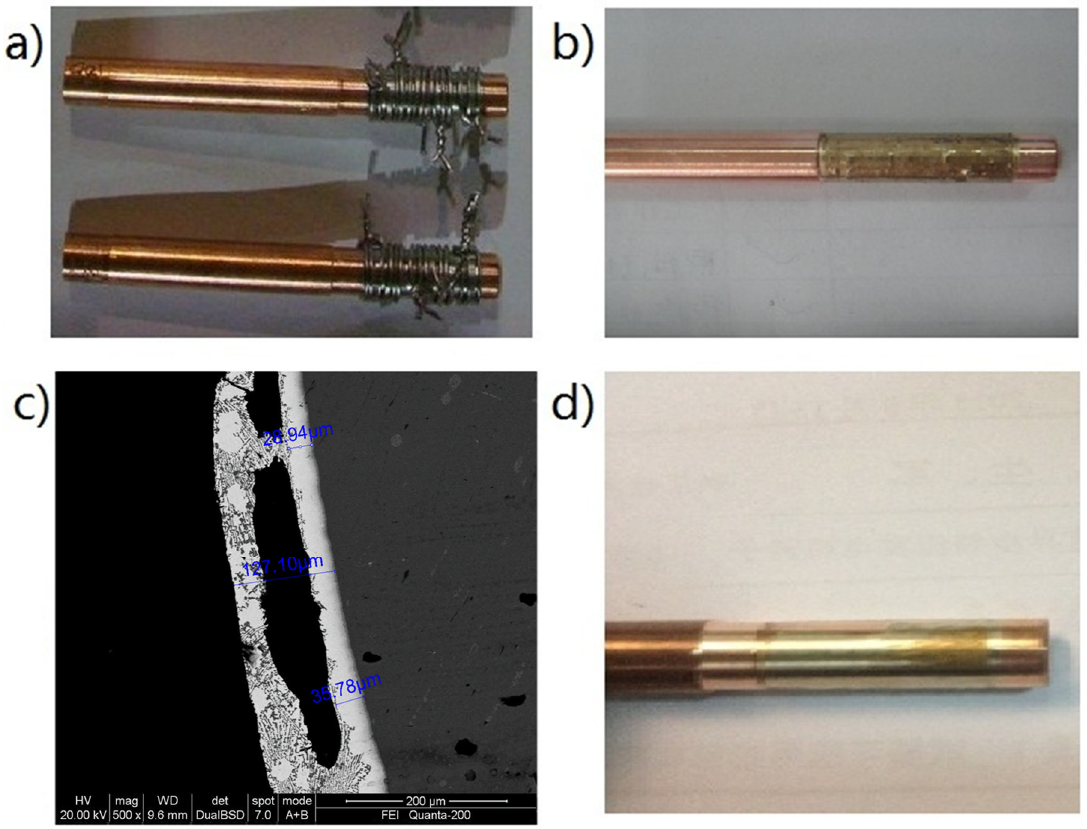
Figure 7. Images of the Cu-Cr-Zr cylinder vacuum-sintered by the solder wrapped by steel wire, ( a ) steel wire wrapped cylinder, ( b ) the solder sintered cylinder, ( c ) the cross-sectional SEM image of the solder sintered cylinder, and ( d ) the solder sintered cylinder after surface cutting.